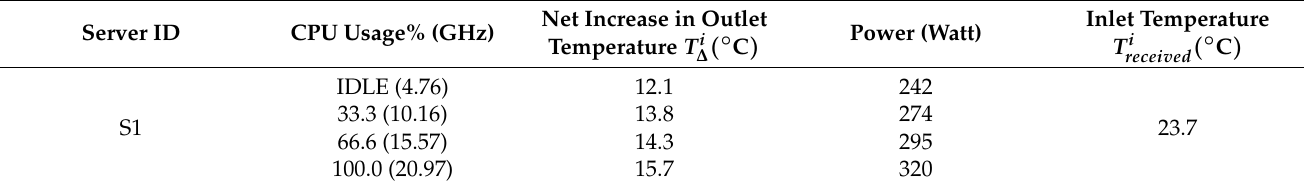
Table 1. A sample thermal profile of a